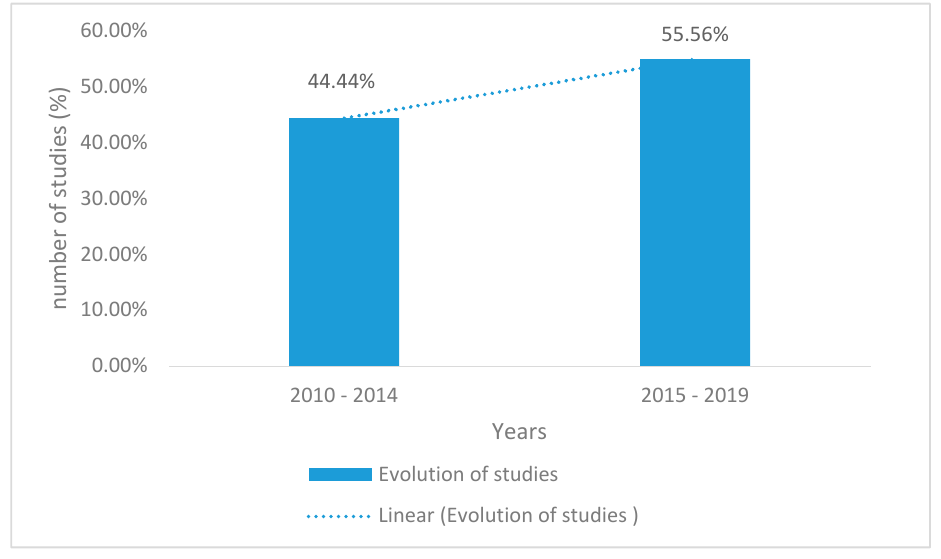
Figure 3. Evolution of the number of studies on child nutritional status in South Africa from the selected studies.